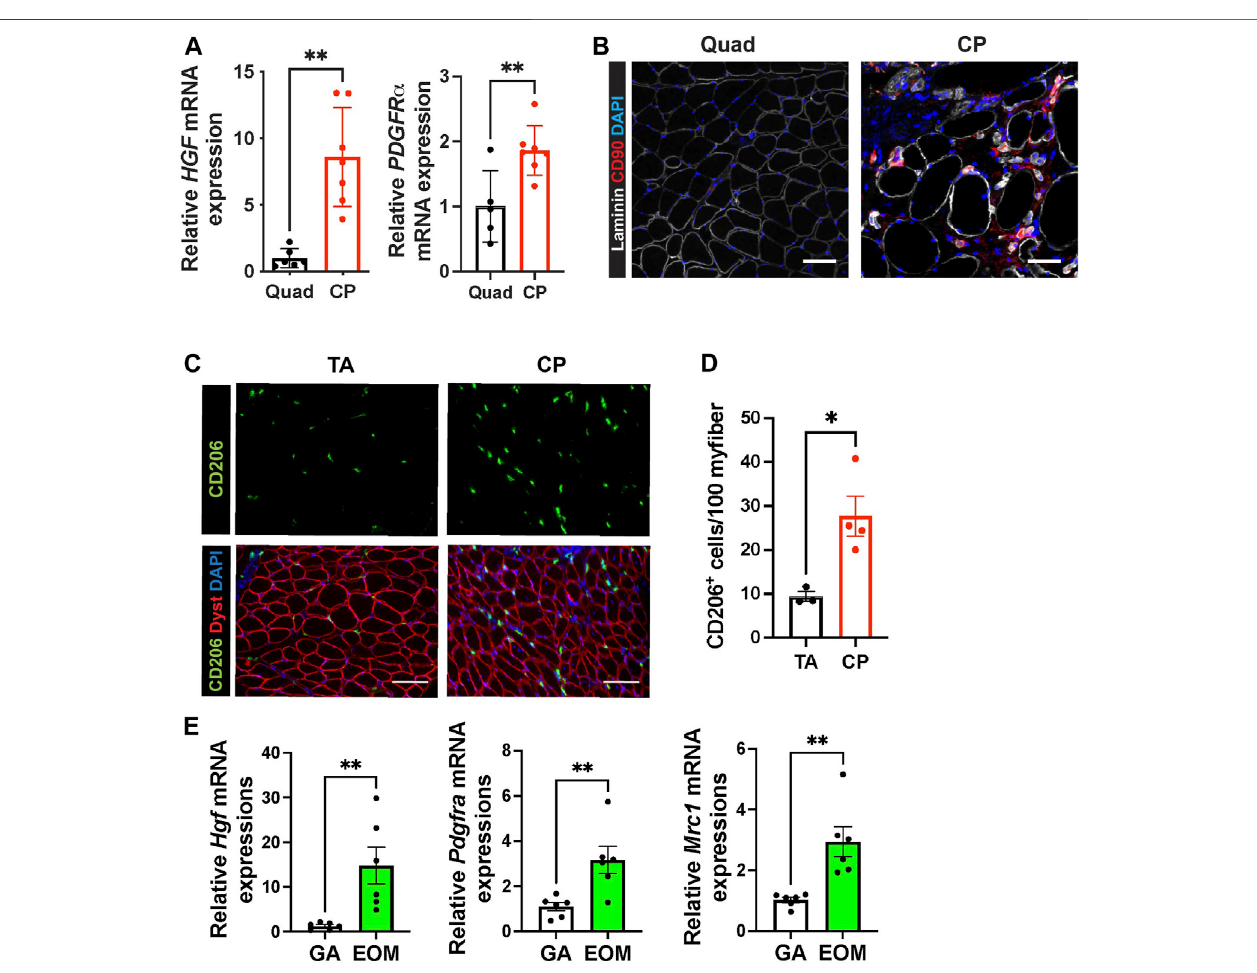
FIGURE 4 | Human pharyngeal muscles and mouse extraocular muscles contain an increased level of hepatocyte growth factor, FAPs, and CD206 + macrophages. (A) Relative mRNA expression level of HGF and PDGFRa in human quadriceps (Quad) and cricopharyngeus (CP) muscles. n = 5 – 7. (B) Representative imagesofCD90 + FAPcellsinhumanquadriceps(Quad)andcricopharyngeus(CP)muscles.Mergedimagesshowimmunostainingwithanti-CD90(red)andanti-laminin (white) antibodies and DAPI (blue). Scale bars = 50 µm. (C) Representative images of CD206 + cells in human tibialis anterior (TA) and cricopharyngeus (CP) muscles. Merged images show immunostaining with anti-CD206 (green) and anti-dystrophin (red) antibodies and DAPI (blue). Scale bars = 130 µm. (D) The quanti fi ed number of CD206 + cells per 100 myo fi bers. n = 3 – 4. (D) Relative mRNA expression level of Hgf , Pdgfra , Mrc1 in mouse gastrocnemius (GA) and extraocular muscles (EOM) n = 6. Statistical signi fi cance was determined by student ’ s t-test (A, D, E) . The value represents mean ± SEM. Asterisks indicate statistical signi fi cance (* p < 0.05 and ** p <